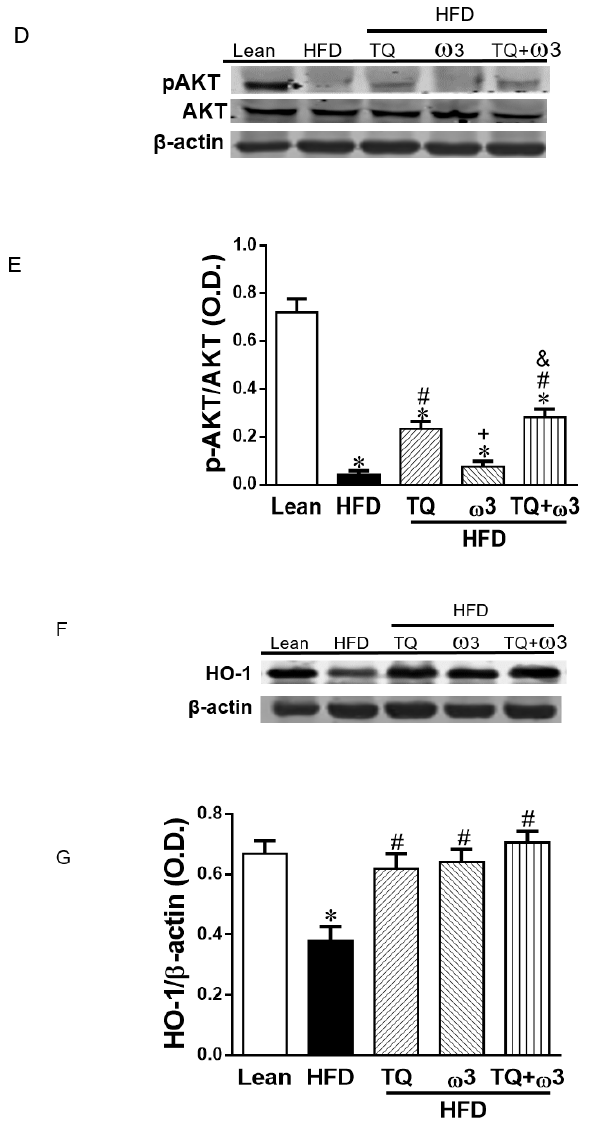
Figure 6. Effects of thymoquinone (TQ) and omega-3 ( ω 3) treatment on 5’ adenosine monophosphate-activated protein kinase (AMPK) and insulin signaling in visceral adipose tissue of mice fed a high-fat diet (HFD). Representative Western blots ( A ) and densitometry analysis of phosphorylated acetyl-CoA carboxylase / acetyl-CoA carboxylase (pACC / ACC) ( B ), pAMPK / AMPK ( C ); Representative Western blots ( D ) and densitometry analysis of p-AKT / AKT ( E ); Representative Western blots and densitometry analysis of HO-1 ( F , G ). n = five animals per group. * p < 0.05 vs Lean; # p < 0.05 vs HFD, + p < 0.05 vs TQ, and & p < 0.05 vs ω 3.